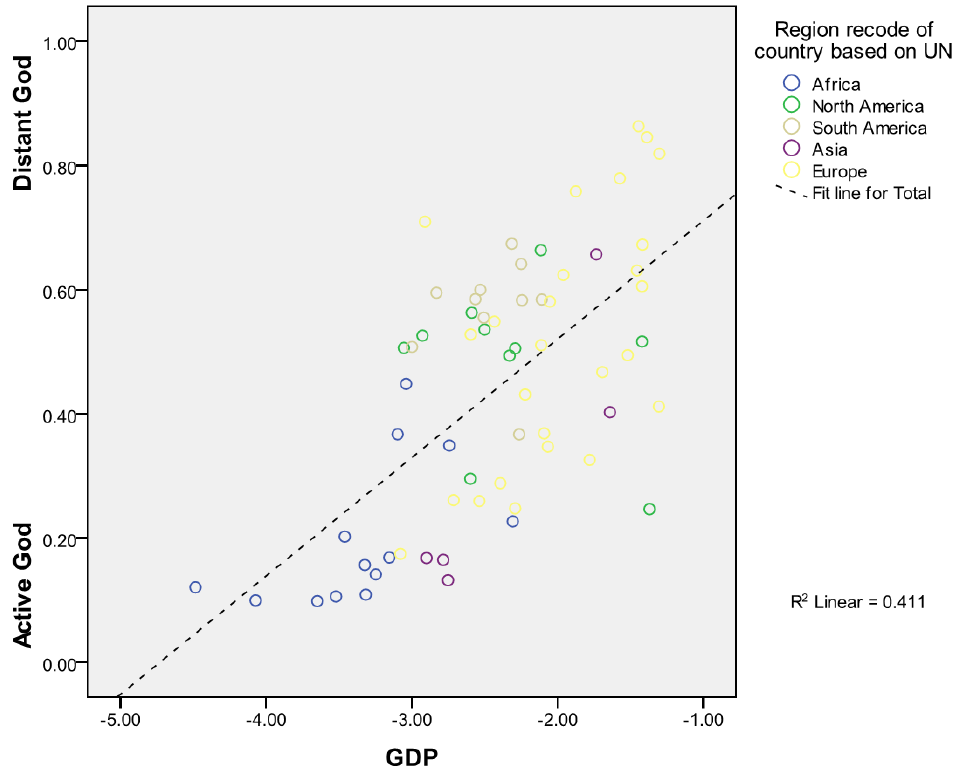
Figure 3. God around the Christian World (correlated with per capita